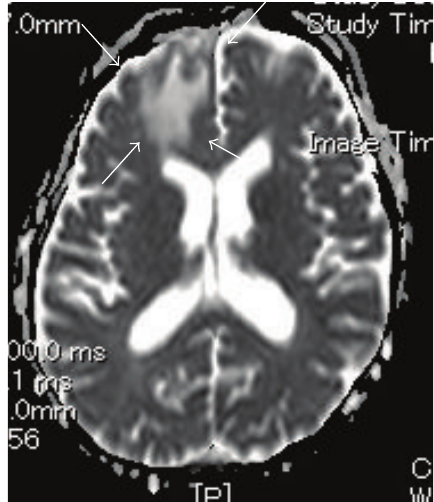
Figure 6: MR imaging (DWI) showing low apparent diffusion coefficient (ADC).